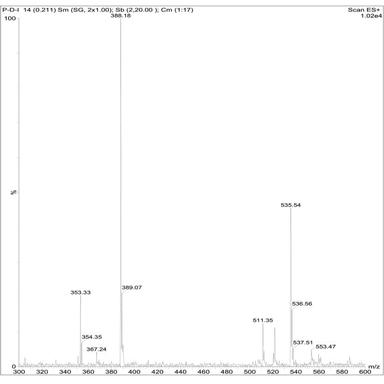
Mass spectrum of DMPI (Magnified) in CH3CN.